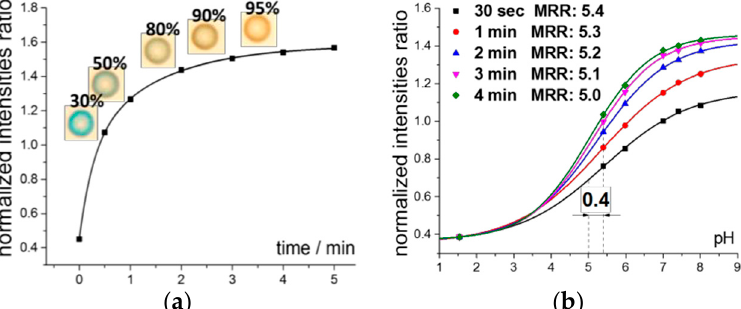
Figure 1. ( a ) The time response of the optode (10 mM/kg ETH5350, 10 mM/kg TBATBB, 80 mM/kg Na VI) to the change from 0.1M HCl to pH 6.5. The numbers in the photographs indicate % of the overall signal change. Symbols: experimental data, line: exponential fitting; ( b ) The response curves of the same optode obtained at different times of contact with the solution (shown in the plot). MRR is the median of the response range. Symbols: experimental data, lines: sigmoid function fitting. Background: 0.2 M